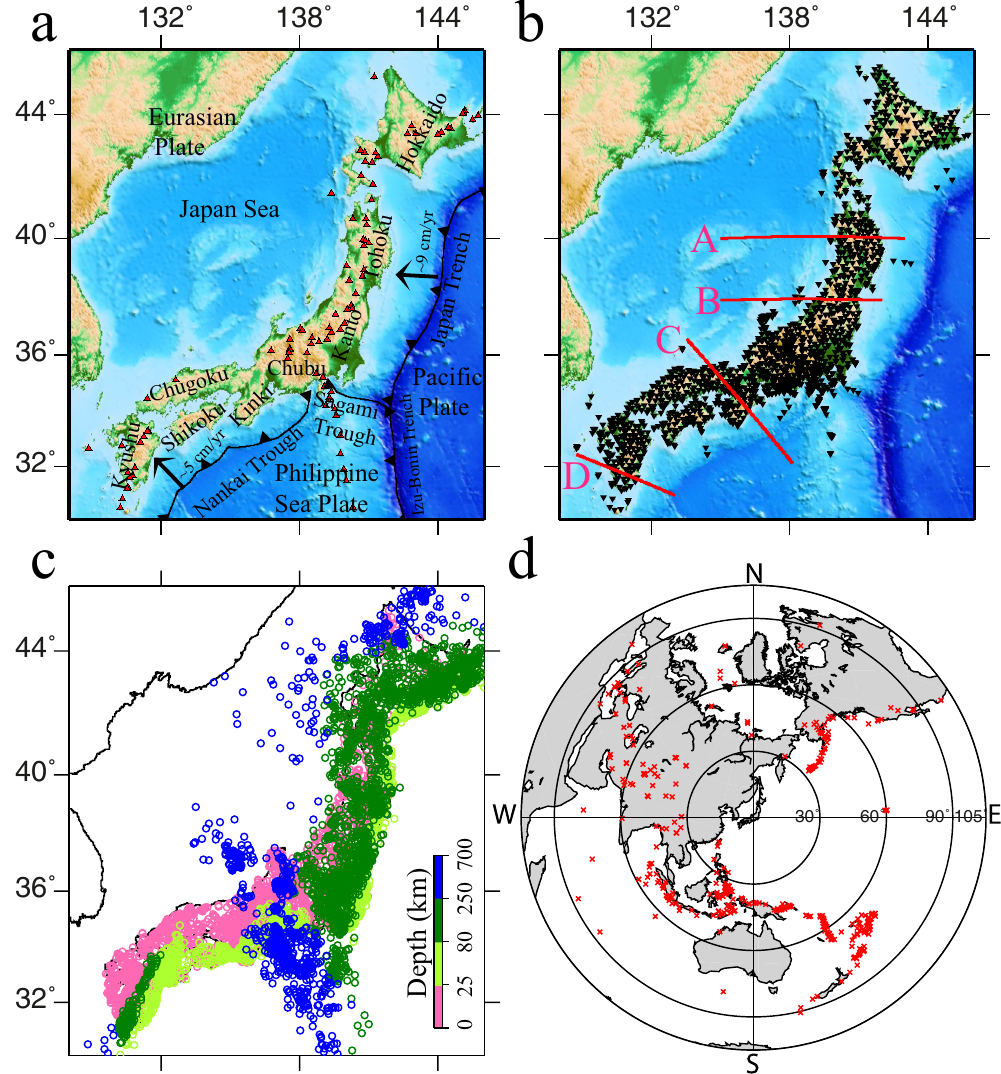
Figure 1. Map of the Japan Islands and surrounding regions. ( a ) Tectonic settings. The red triangles denote active arc volcanoes. ( b ) Distribution of 1656 seismic stations (black triangles) used in this study, which belong to the Japanese national universities, Japan Meteorological Agency (JMA), and the High-sensitivity seismic network (Hi-net). The red lines show locations of the four profiles shown in Fig. 3. ( c ) Epicentral distribution of 7350 local earthquakes (color circles) used in this study. The colors denote the focal depths. ( d ) Epicentral distribution of the 376 teleseismic events (red crosses) used in this study. This Figure is generated using GMT 4.5.3 (http://www.soest.hawaii.edu/gmt/) developed by Wessel and Smith 59